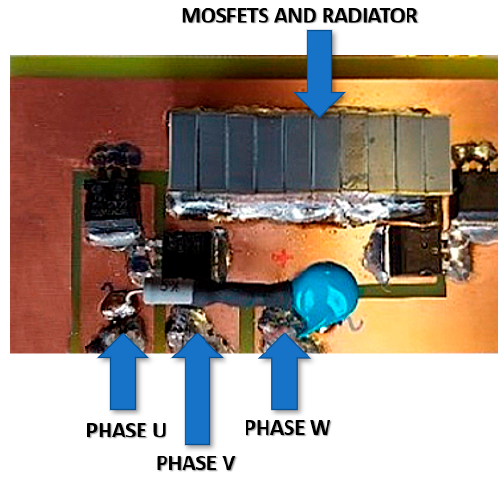
Figure 18. SMD active rectifier: first SMD prototype.